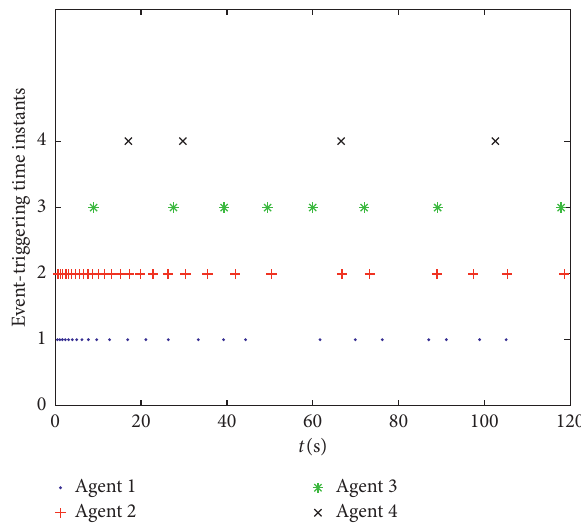
Figure 10: Event-triggering time instants of each agent when τ � 0.01.